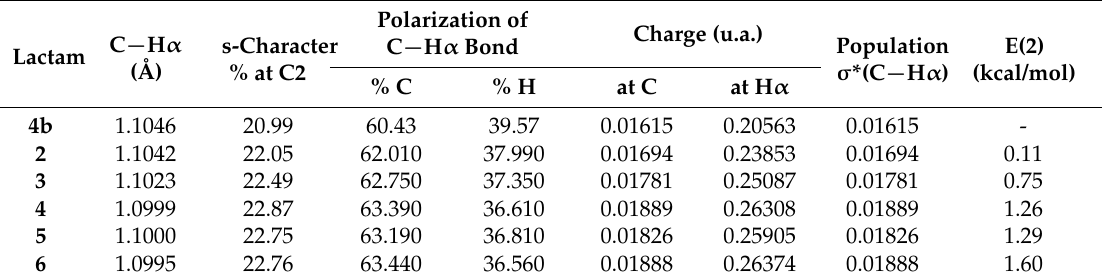
Table 3. C − H Distance and NBO analysis in closed conformers. The data for 4 open ( 4b ) is used as reference.